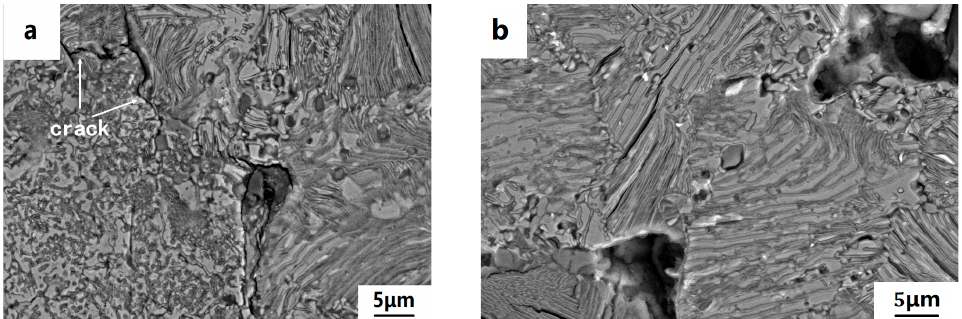
Figure 9. SEM morphology of porous samples reduced by H 2 after polarization tests: ( a ) H700; ( b ) H1100.